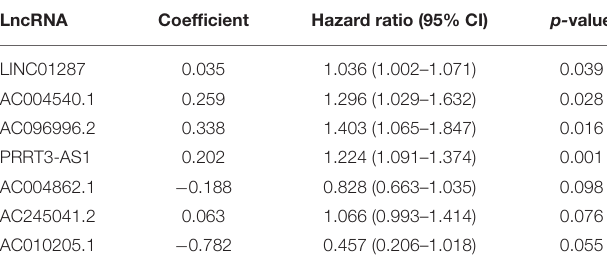
TABLE 2 | Seven lncRNAs identified using the Cox regression